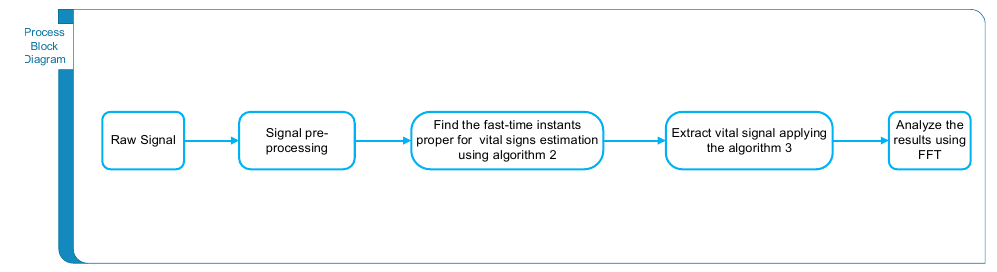
Figure 3. Process block diagram for extraction of driver vital signs.